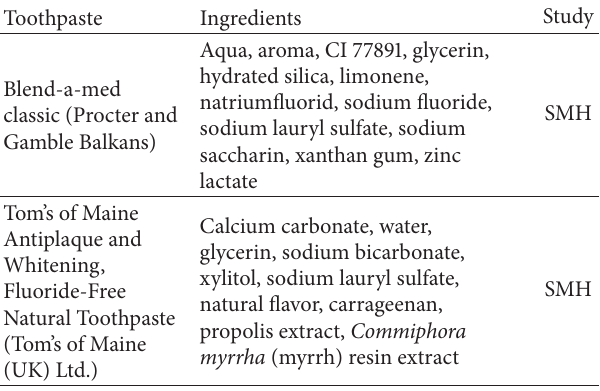
Table 2: Toothpastes used in the SMH